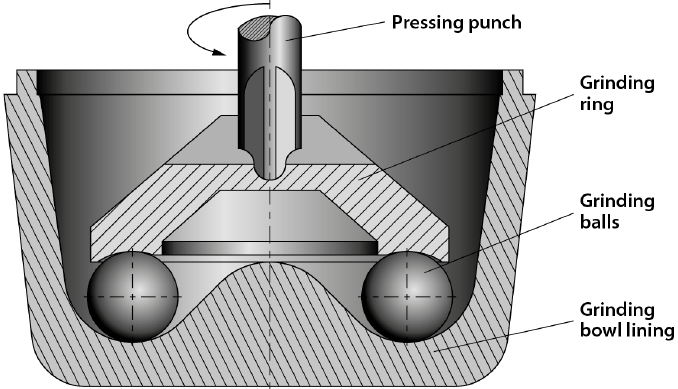
Figure 2. A cross-section of the Hardgrove ball-ring mill. Self-prepared based on [30]. The total weight of the grinding ring pressing the grinding balls, three weights and the punch with the toothed wheel should be 29.0 ± 0.2 kg. The rotational speed of the upper grinding element should be between 19 and 21